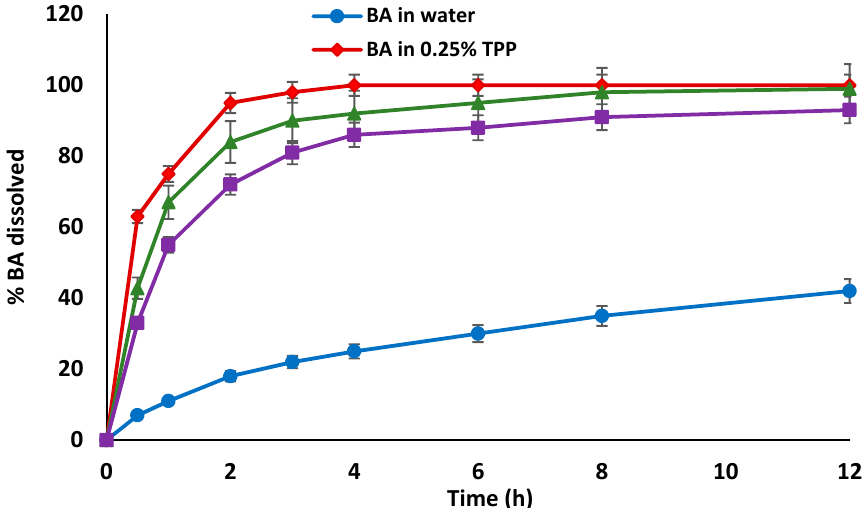
Figure 4. In vitro release profiles of BA from its solution in 0.25% TPP, BA-loaded-LA-free-CL-NPs and BA-loaded-LA-modified-CL-NPs in phosphate buffer (pH 6.8) at 37 °C in comparison to the in vitro release of BA from its dispersion in distilled water. Data points are mean ± SD ( n = 3).